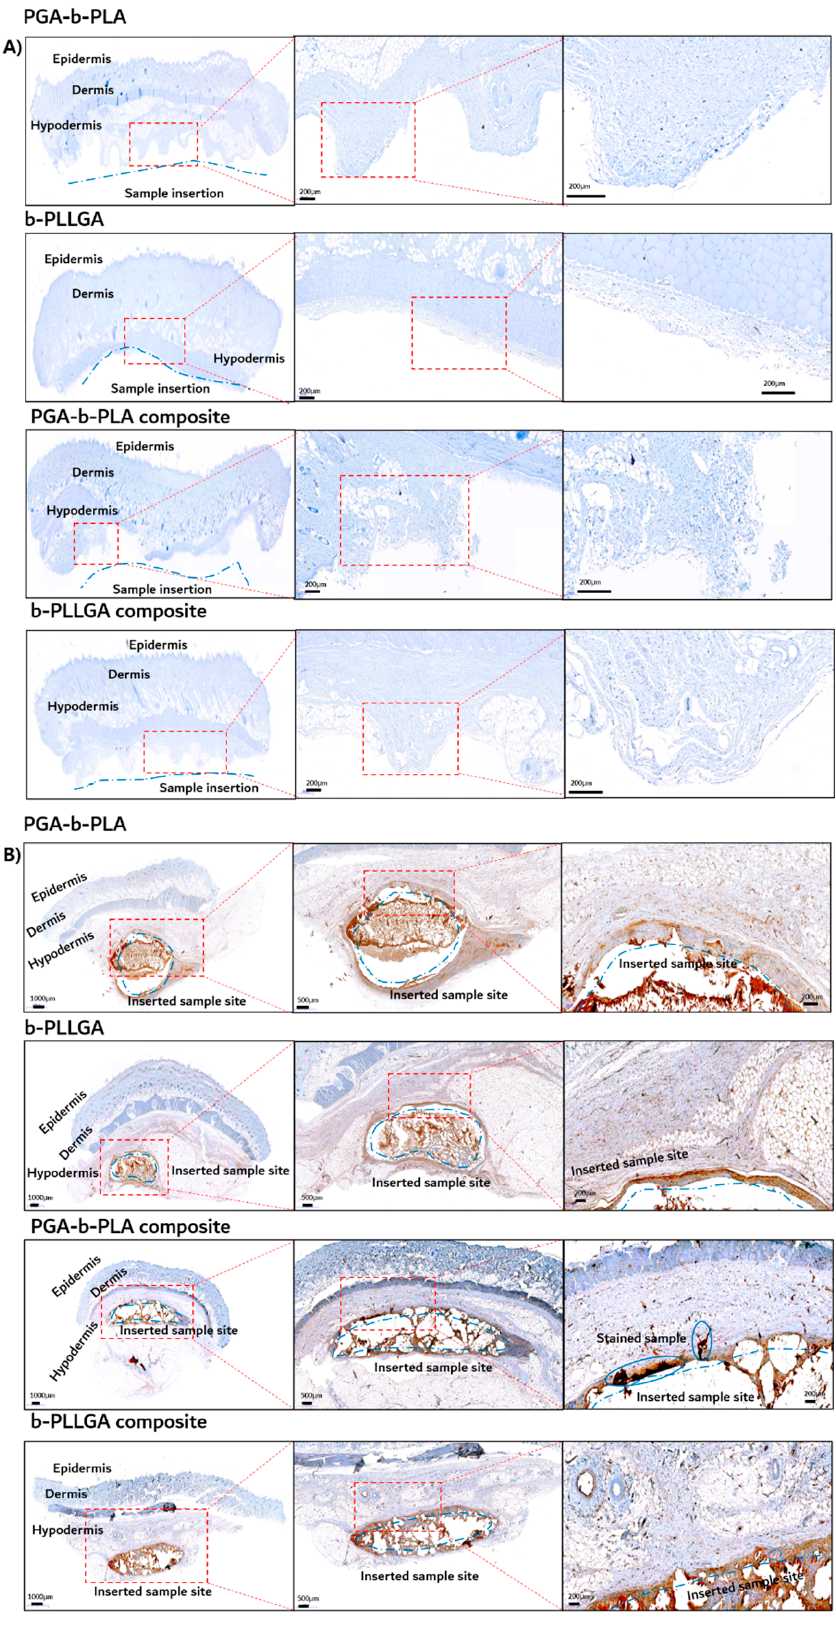
Figure 11. Histochemical analysis of the in vivo animal degradation test using immune staining with insertion after 1 month ( A ), immune staining with insertion after 5 months ( B ) (antibody: CD- 1 month ( A ), immune staining with insertion after 5 months ( B ) (antibody: 68).